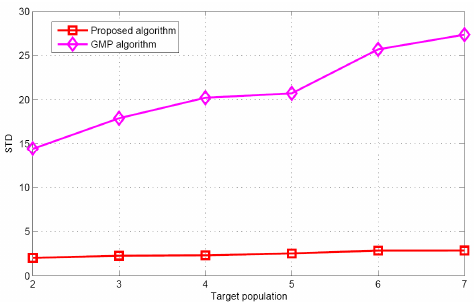
Figure 6. The STD of the estimated target populations versus target population.